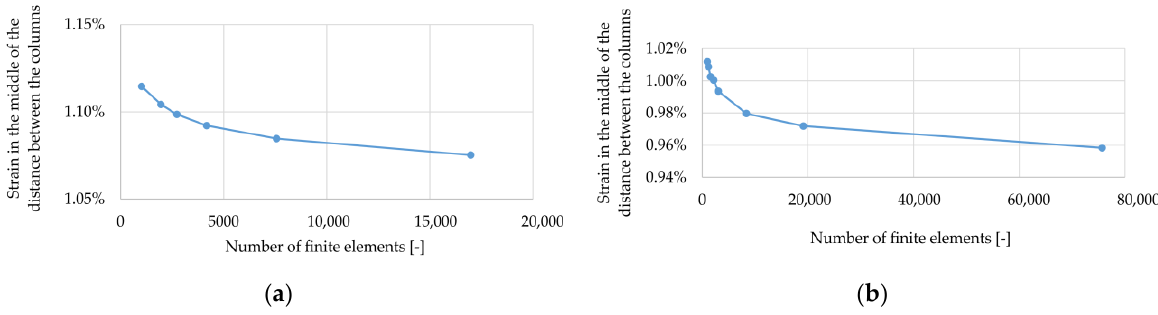
Figure 5. Strains at point C (see Figure 2) depending on the number of elements: ( a ) variant B1; ( b ) variant B2.